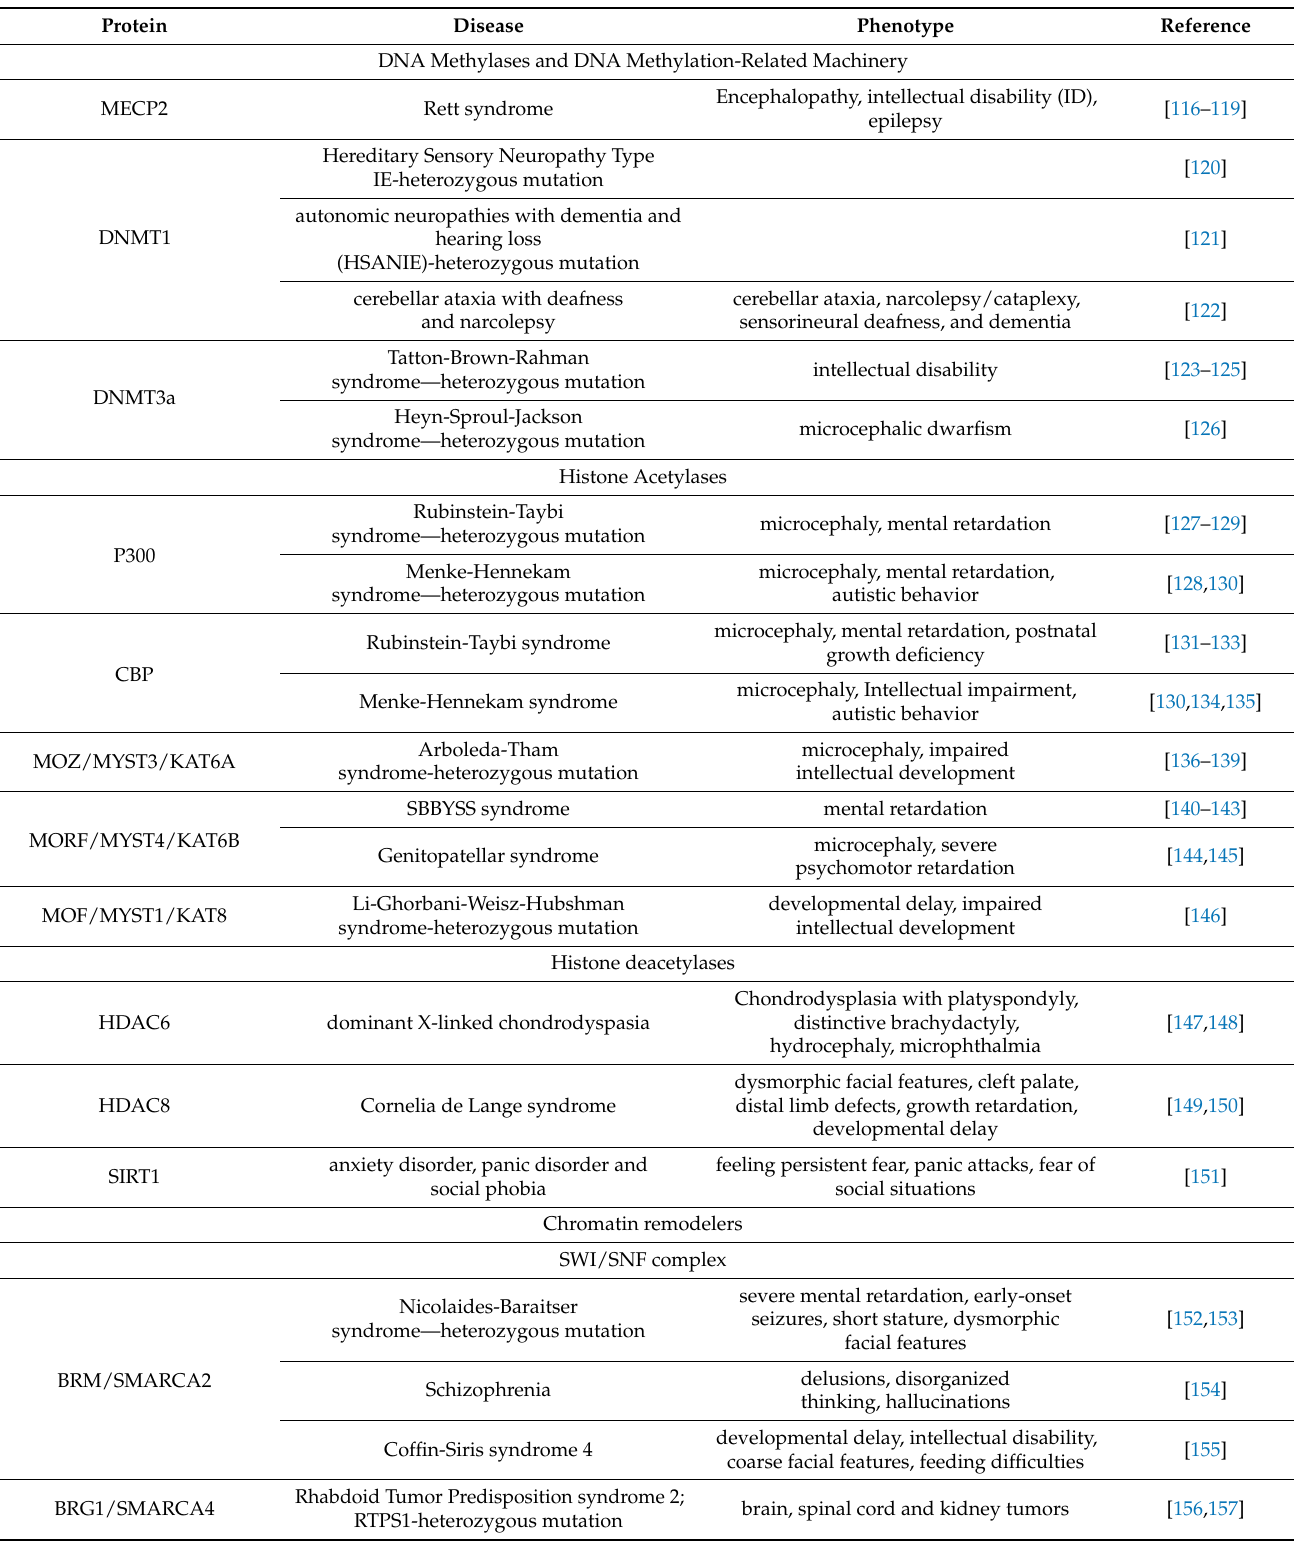
Table 1. Chromatin-related factors implicated in